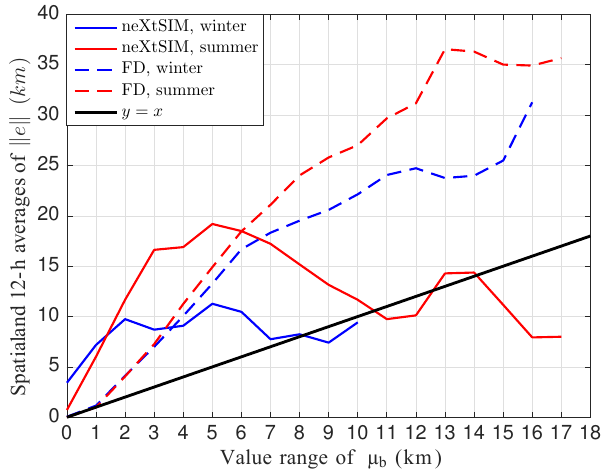
Figure 18. Spread–error relationship for 12h averages. The curves are based on the spatial mean of the forecast error shown as a func- tion of the